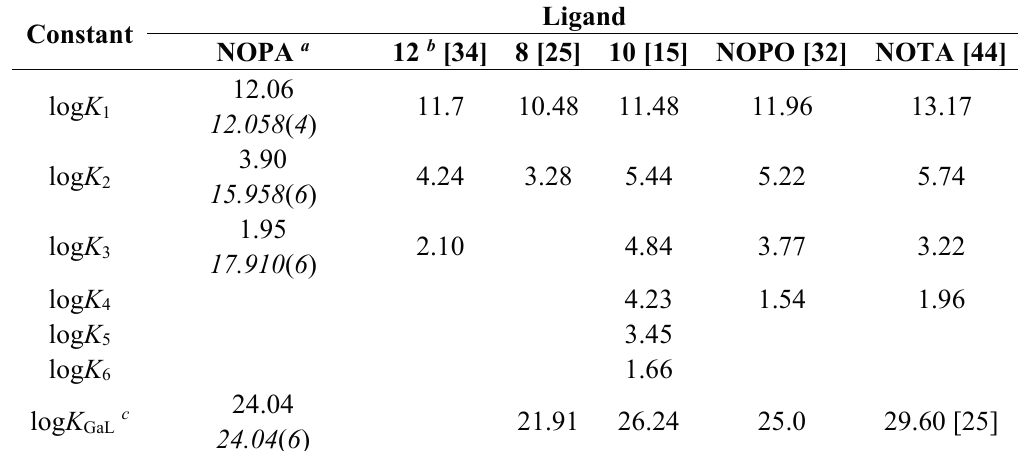
Figure 3. Species distribution diagram of the Ga 3+ -NOPA system. Table 1. Stepwise protonation (log K n ) and thermodynamic stability (log K GaL ) constants of free ligands and their gallium(III) complexes, respectively (25  C, I = 0.1 M (Me 4 N)Cl). Literature data are given for